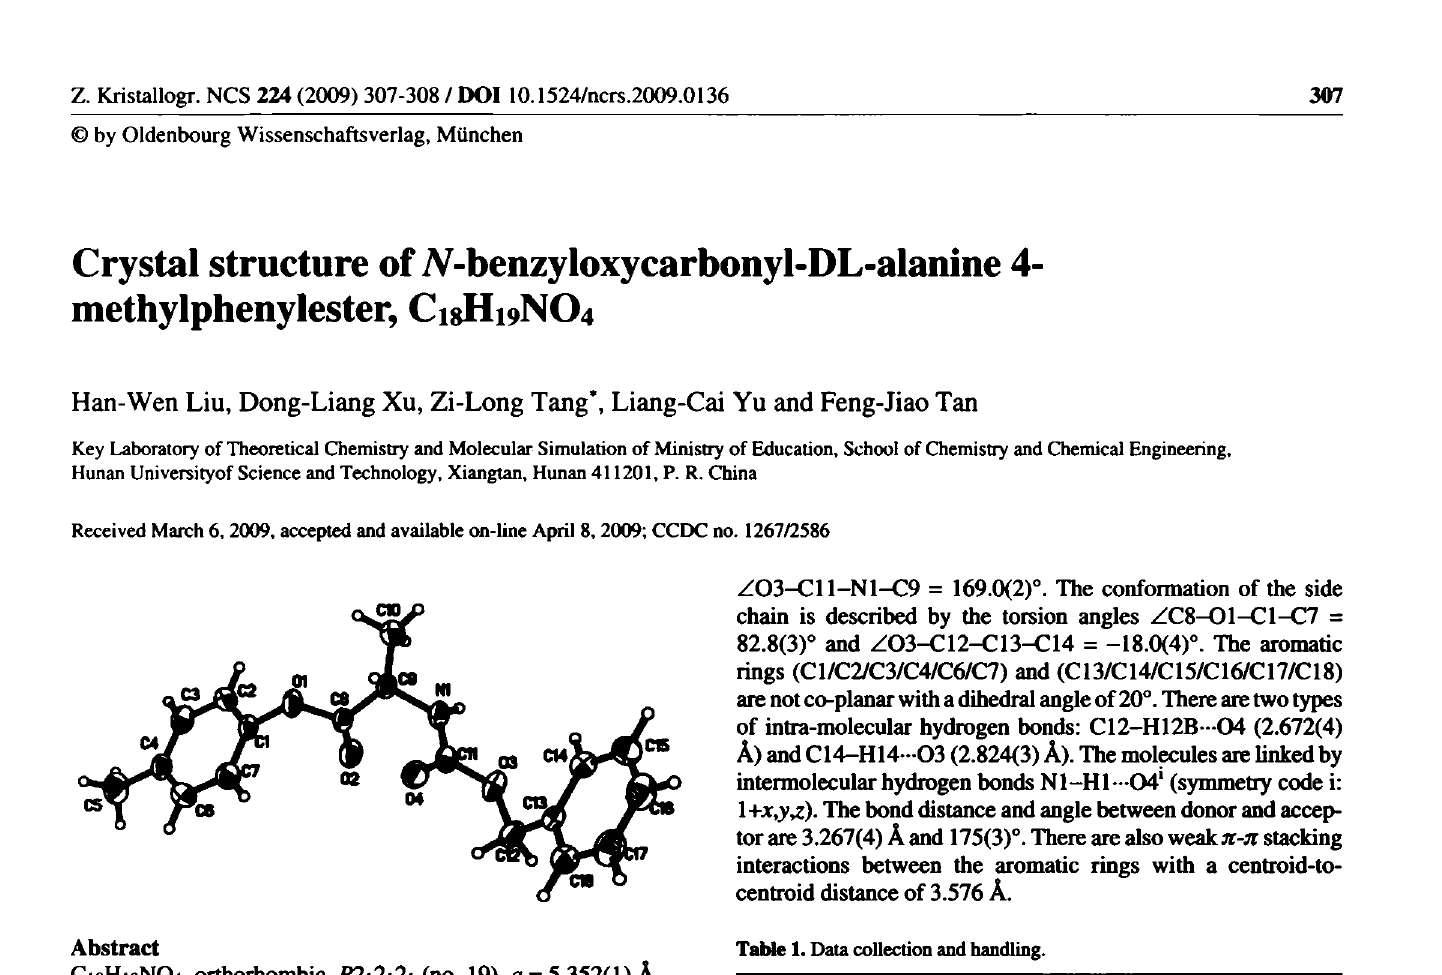
Table 2. Atomic coordinates and displacement parameters (in Â 2